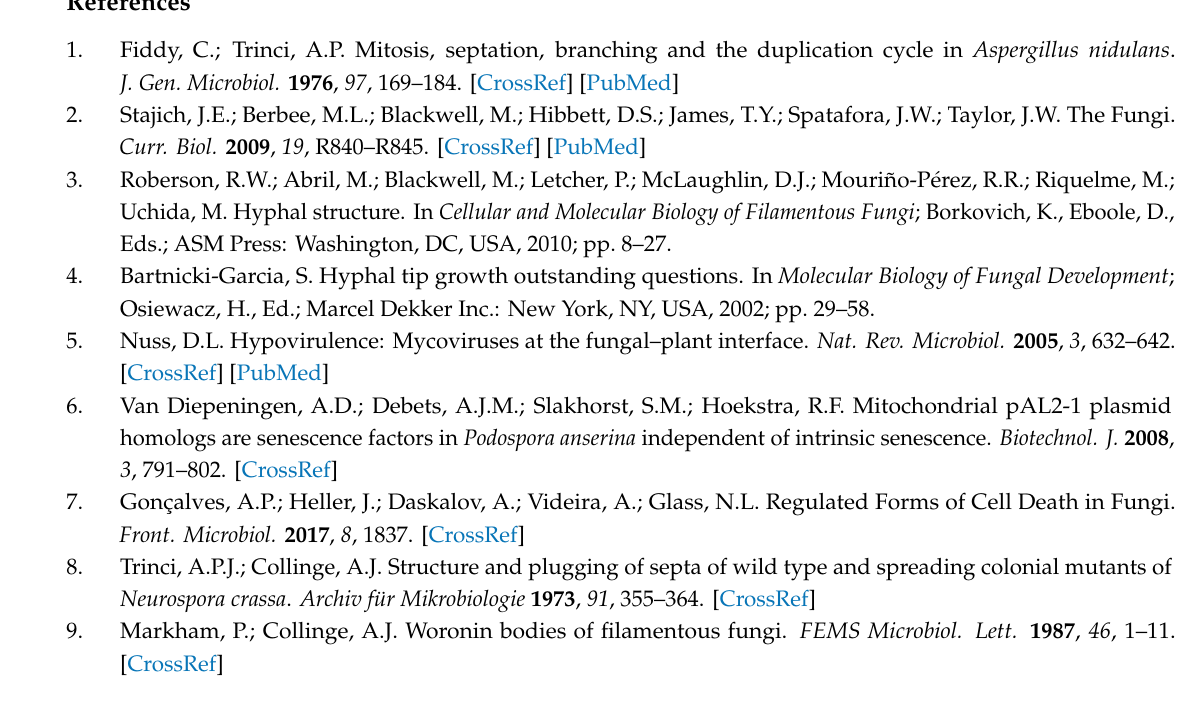
Figure S1. Multiple sequence alignment of Hex1 homologs of V. dahliae and other selected ascomycetes, for comparison; Figure S2. Schematic representation of the strategy followed for hex1 deletion in V. dahliae ; Figure S3. Morphological characteristics of hyphae of the wild-type and the ∆ hex1 strains; Figure S4. E ff ects of antifungal agents on ∆ hex1 ; Figure S5. Vdhex1 is not involved in heterokaryon incompatibility; quantification of blue fluorescence intensity (calcofluor white M2R staining of cell wall chitin) of septae and cross-section of the fused cells (additional to Figure 7); Figure S6. Nuclear copy number per hyphal compartment in mycelia of the V. dahliae BB wild-type and ∆ hex1 strains; Table S1. Verticillium dahliae strains constructed and used in this study; Table S2. List of DNA oligonucleotides used in this study; Table S3. List of plasmids constructed and used in this study; Table S4. Results from the heterokaryon compatibility tests between nit mutants of V. dahliae isolates; Video S1. Time-lapse microscopic examination of a fusion event between the incompatible strains BB ∆ hex1 H1-sGFP and Ls.17 sGFP (additional to Figure 7A); Video S2. Time-lapse quantification of blue fluorescence intensity (calcofluor white M2R staining of cell wall chitin) in the region of interest shown in Video S1 (additional to Figure 7B); Video S3. Nuclear migration through the septal pore, in BB ∆ hex1 H1-sGFP (calcofluor white M2R staining of cell wall